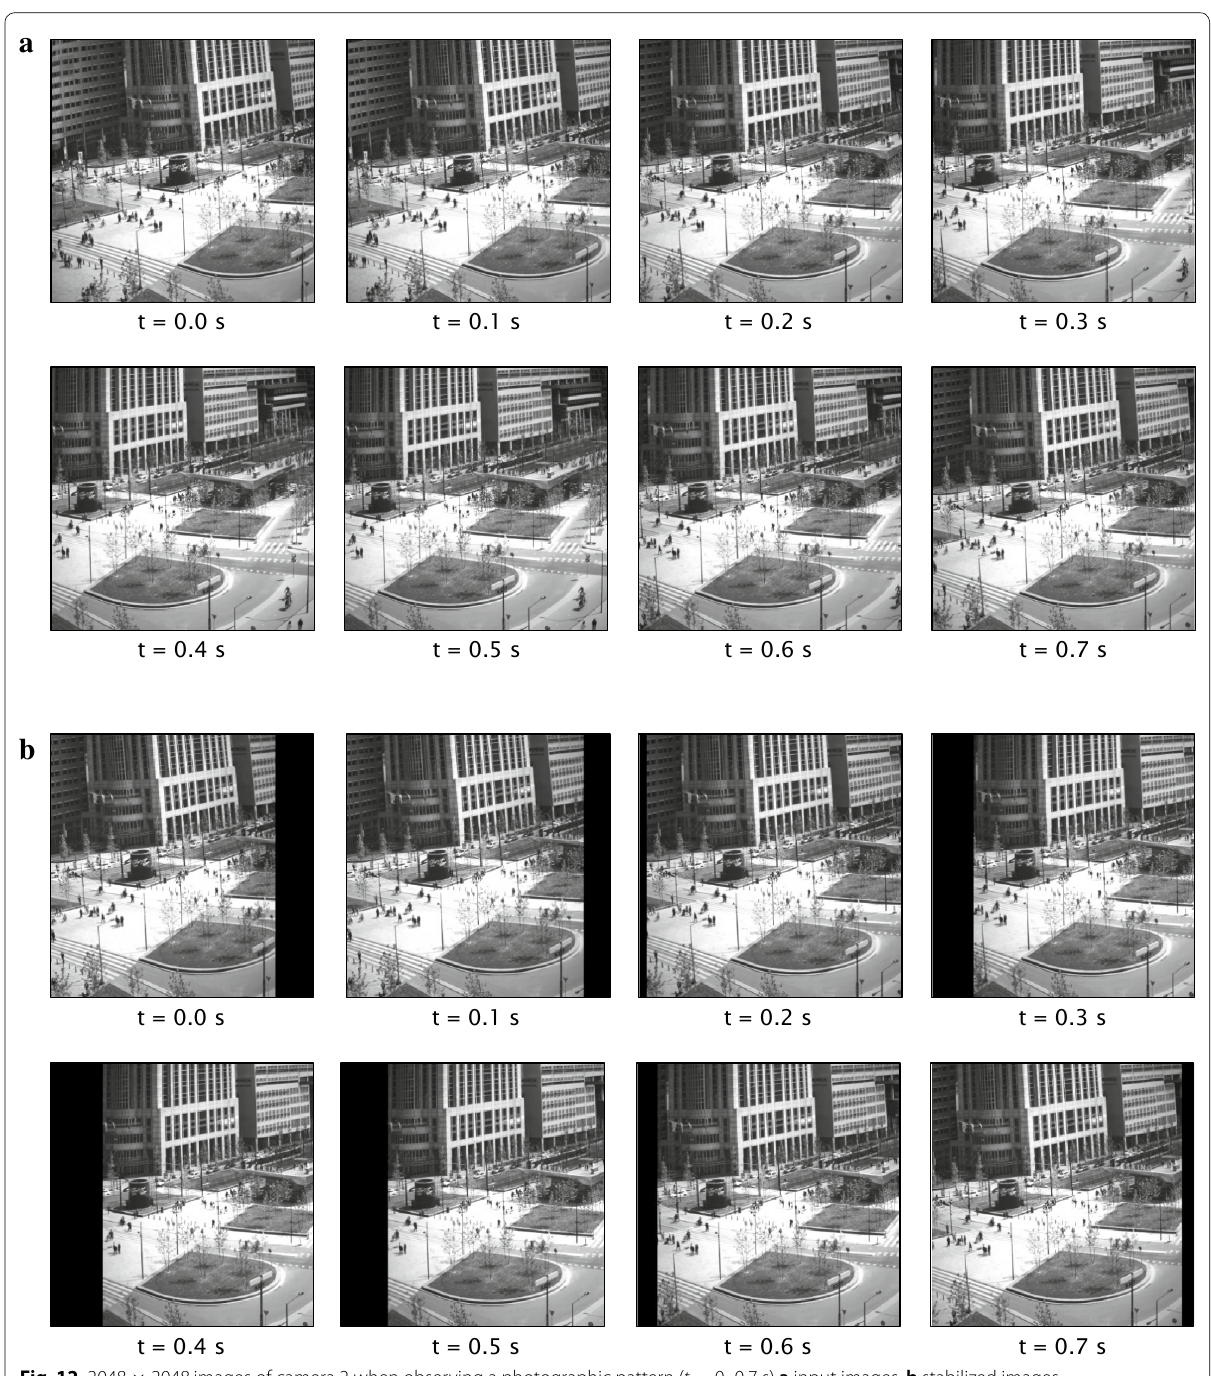
Fig. 12 2048 × 2048 images of camera 2 when observing a photographic pattern ( t = 0–0.7 s) a input images, b stabilized